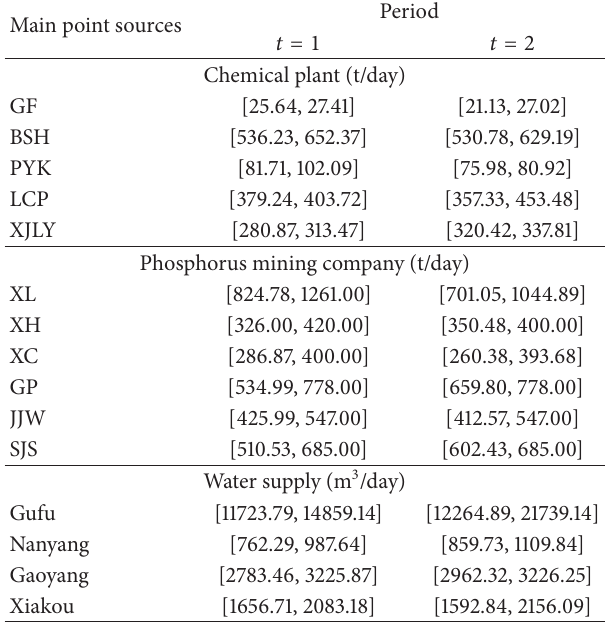
Table 3: Allowable BOD and TP discharges. Table 4: Solutions for industrial productions and water